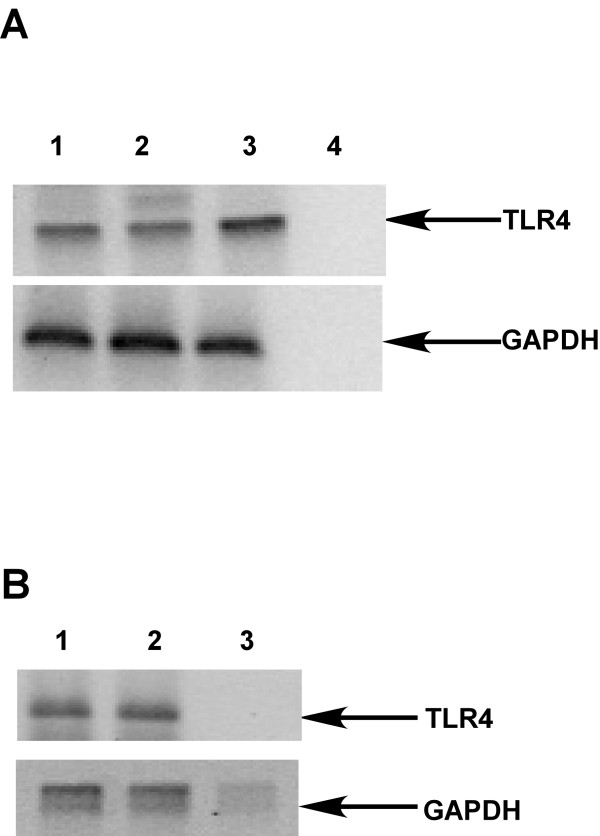
Expression of TLR4 mRNA in NB-1 and SK-N-SH neuroblastoma cells. A, NB-1 cells were incubated with LPS at 100 ng/ml for 4 h. Untreated NB-1 (1), LPS-treated NB-1 cells (2) and untreated U937 cells (3) were analyzed by RT-PCR. B, SK-N-SH cells (l) and U937 cells (2) were analyzed by RT-PCR. GAPDH mRNA was used as an equal loading control. Lane 4 and Lane 3 of each figure is used as a negative control respectively i.e RNA without reverse transcriptase enzyme (R.T). Data is the representative of at least three independent experiments.